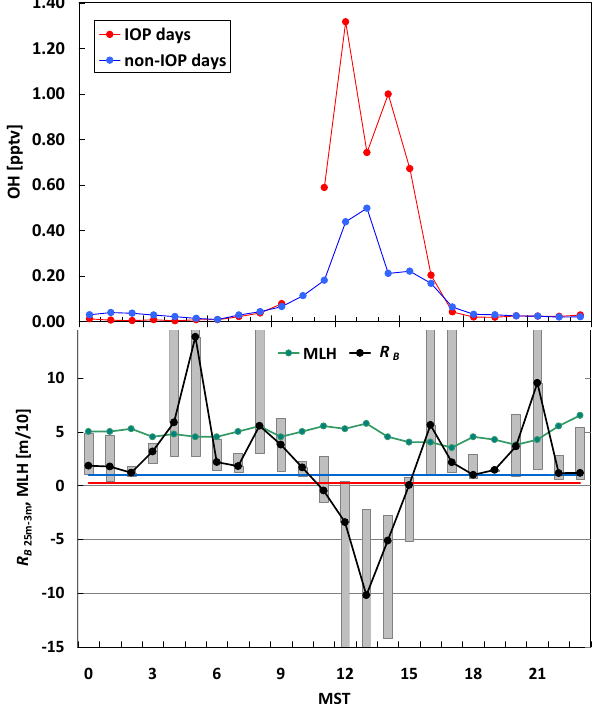
Figure 14. Top: OH mixing ratios calculated based on equation (14) on IOP and non-IOP days as determined at the measurement height 1.80m above the surface. Bottom: median diurnal variation of the mixing layer height (MLH) and the bulk Richardson number on IOP days between the levels 3 and 25m above the ground level as ob- tained at the Tall Tower site. The blue line indicates R B = 1, above which the flow is considered to be laminar. The right line indicates R B = 0 . 25, below which the flow is considered to be turbulent. Ad- ditionally, 0 . 25 < R B < 1 indicates a transitional range, where the flow can be either laminar or turbulent depending on its history.